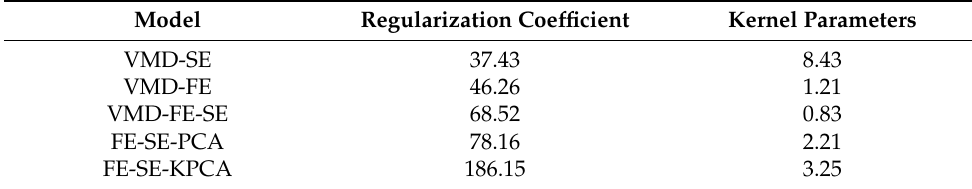
Table 5. Optimization results of KELM model parameters for different feature